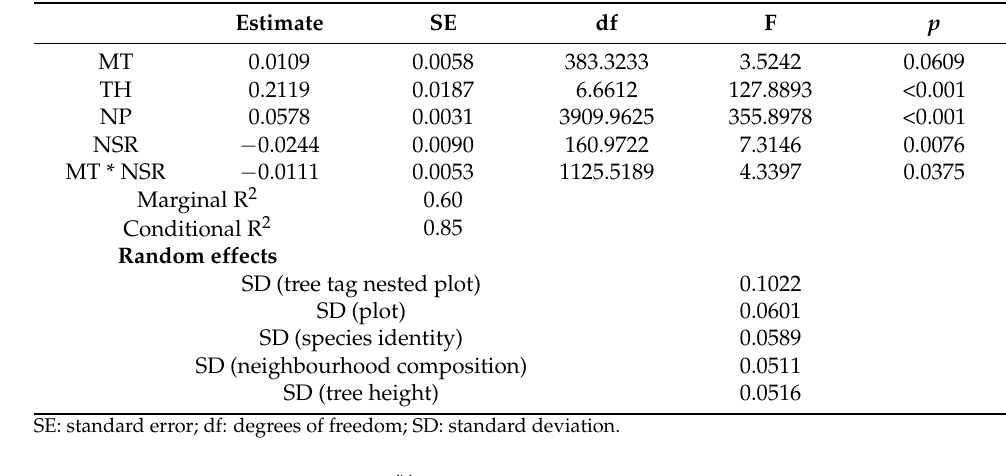
Table 1. Results of mixed-effects model of microtopography (MT), target tree height (TH), neigh- bourhood pressure (NP, square root-transformed), neighbourhood tree species richness (NSR), and the interaction between MT and NSR on crown displacement (square root-transformed). Parameter estimates are standardised and represent the effect size of the covariates in the model. n = 4004.